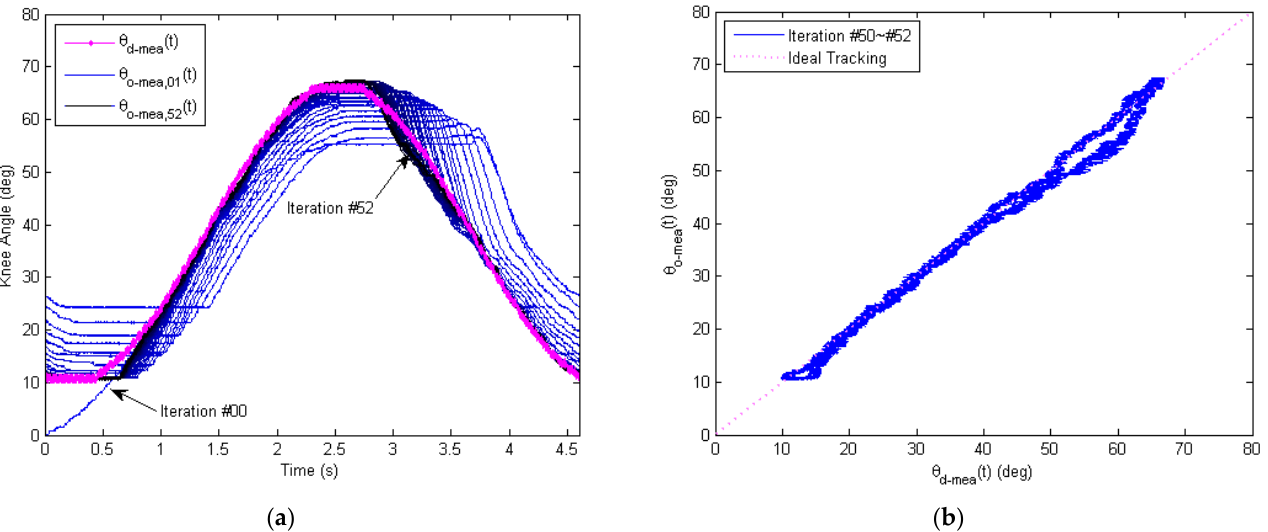
Figure 17. Measured tracking performance using the proposed learning-based repetitive controller, where the learning gain is ϕ = 0.25, and the phase-lead compensation level is γ = 10. ( a ) Convergence history for the exoskeleton knee joint angle in time domain, with iterations #00 to #52 overlapped. ( b ) X–Y plot of the desired knee angle θ d − mea ( t ) against the measured output knee angle θ O − mea ( t ) for iterations #50 to #52. With the outer learning loop, the frictional hysteresis of the Bowden transmission cable is significantly reduced after learning, as compared with Figure 15b where only the inner PD loop is active.